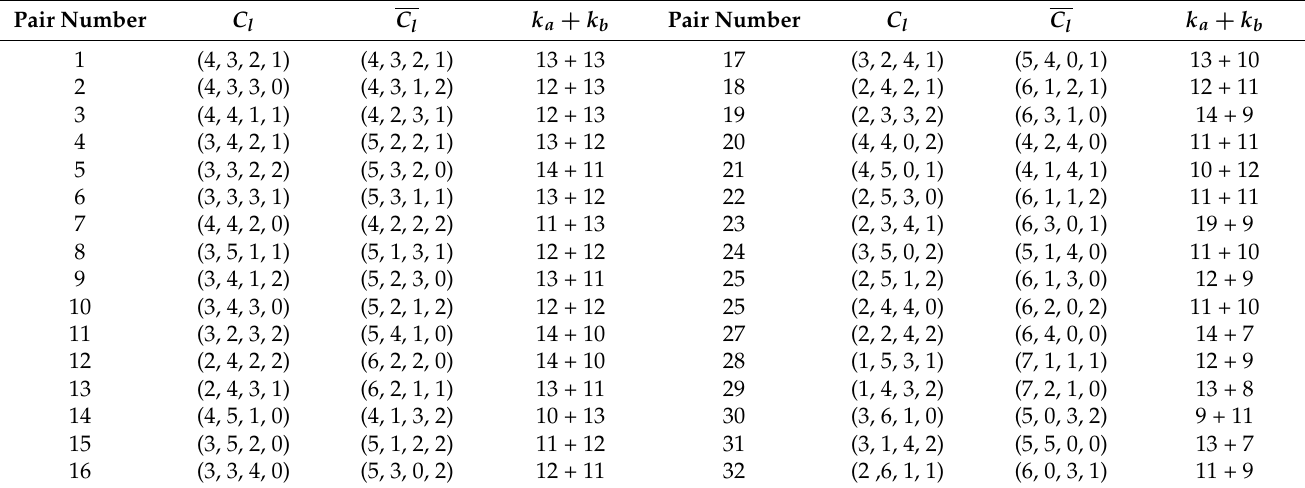
Table 1. The specific parameters of each complementary pair when n = 10, C typ =